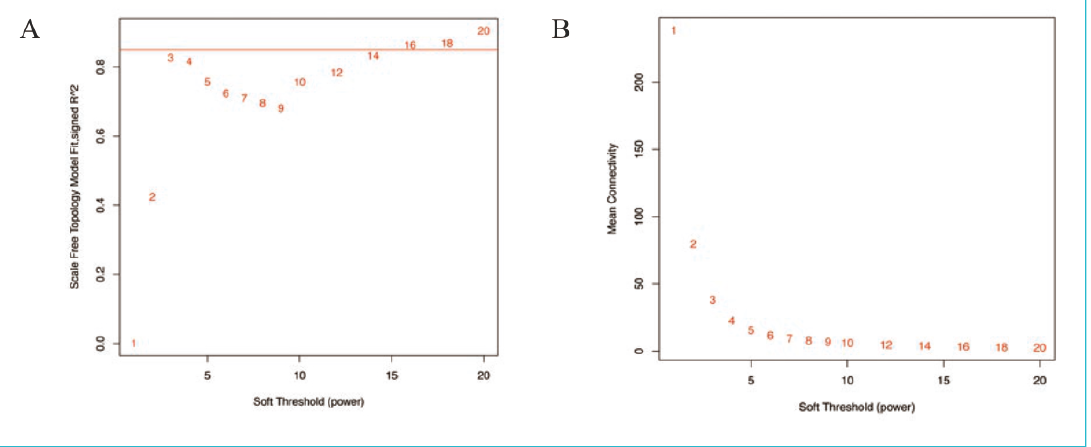
Figure 1: Network topology for different soft-thresholding powers. (A) Numbers in the plots indicate the corresponding soft-thresholding pow- ers. (B) The approximate scale-free topology can be attained at a soft-thresholding power of 16.